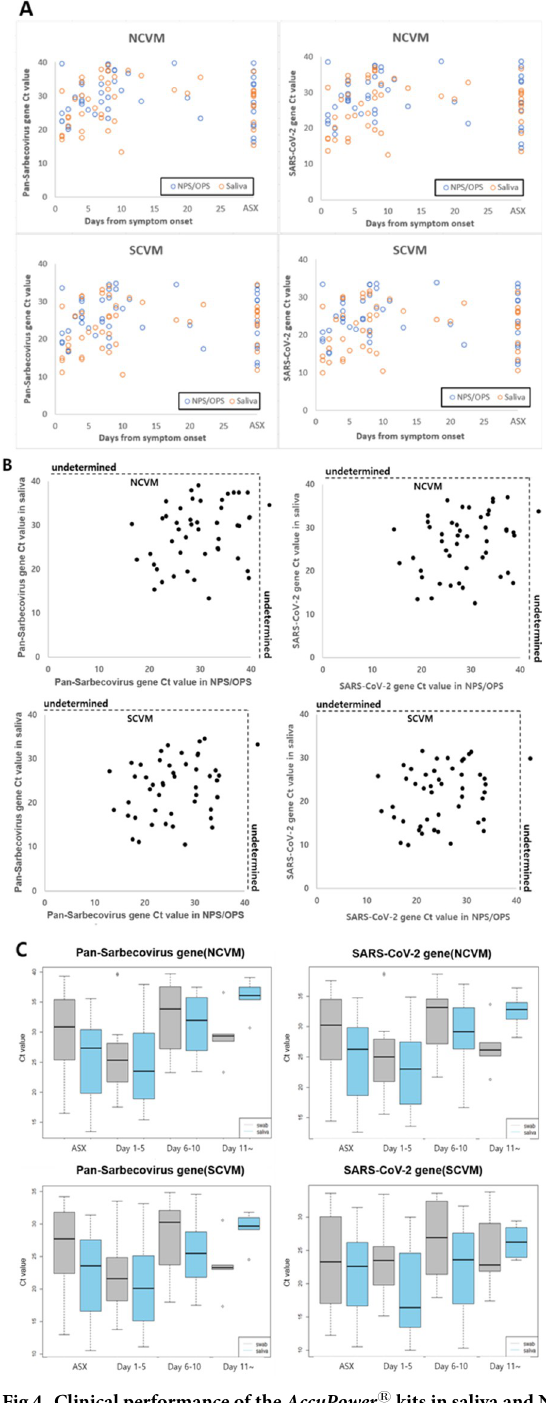
Fig 4. Clinical performance of the AccuPower 1 kits in saliva and NPS/OPS samples. (A) Ct values of saliva and NPS/OPS samples from patients in various stages of COVID-19. (B) Clinical performance comparison of the AccuPower 1 kits in saliva and NPS/OPS samples shown in scatter plots. (C) Ct value comparison by boxplot among the NCVM and SCVM. ASX, Asymptomatic.